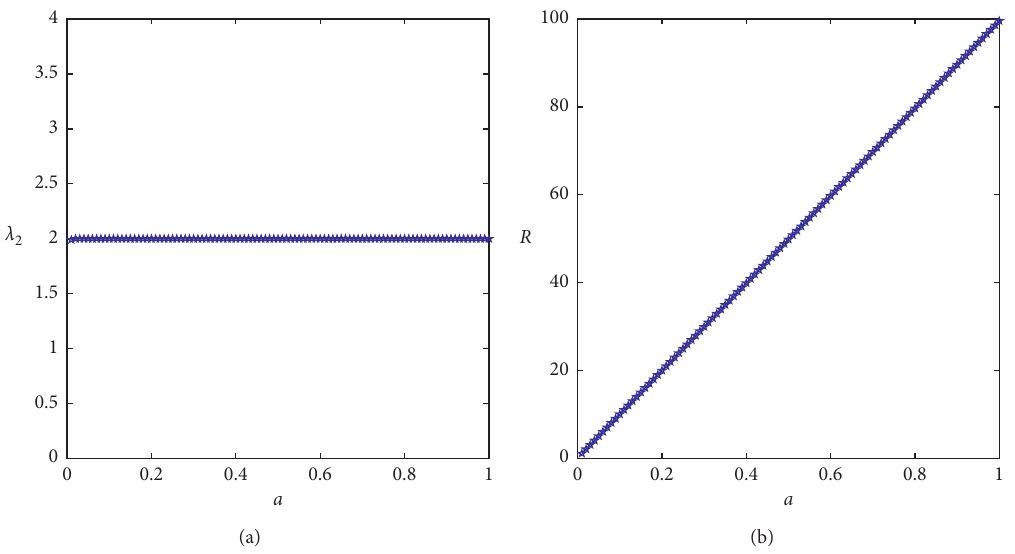
Figure 16: When N is even, the synchronizability of Network II changes with the intralayer coupling strength a from the leaf nodes to the hub nodes. (a) λ changes with a ( a changes from 0.01 to 1); (b) R changes with a ( a changes from 0.01 to 2 Figure 18. The synchronizability